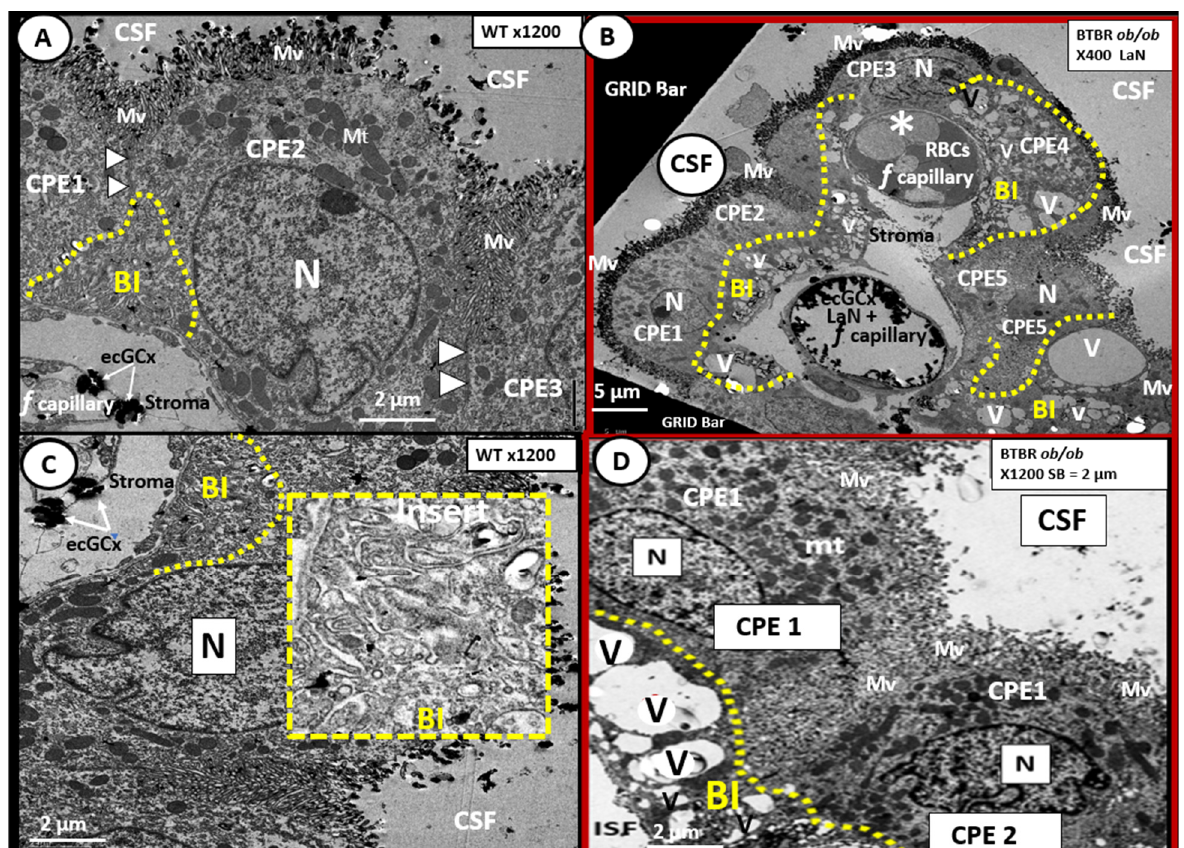
Figure 14. Choroid plexus (lateral ventricle) with aberrant vacuolization of the basilar infoldings of ependymal cells in obese diabetic female BTBR ob/ob models. Panel A demonstrates the normal ultrastructural morphology of the choroid plexus ependymal cell(s) (CPE) in the control heterozygous model, characterized by compact basilar infoldings (BI) (yellow dashed line), tight and adherens junctions (TJ/AJ) (arrowheads), microvilli (Mv) of the brush border at the apical cerebrospinal fluid (CSF) interface, and the multiple electron dense mitochondria (Mt) in a highly polarized ependymal cell. Panel B depicts aberrant remodeling changes of the (BI) at lower magnification to include multiple CPEs (CPE 1–5) which consist of vesiculation (v)/vacuolization (V) of the BI (yellow dashed lines). Importantly, note the lower fenestrated ( f ) capillary with positive staining for lanthanum nitrate (LaN) of the endothelial glycocalyx (ecCGx) and the upper capillary (*) that is filled with multiple red blood cells (RBCs) that is highly suggestive of capillary micro-thrombosis and without evidence of LaN staining. Panel C also illustrates the control heterozygote CPEs and this image contains an exploded insert of the BI (outlined in yellow dashed lines). This insert illustrates the compactness of the BIs without v/V. Panel D depicts the v/V of the BI as compared to the control models in Panels A and C . Magnification × 400; scale bar = 5 µ m in Panel B and magnification × 1200; scale bar = 2 µ m in Panels A–D . n =